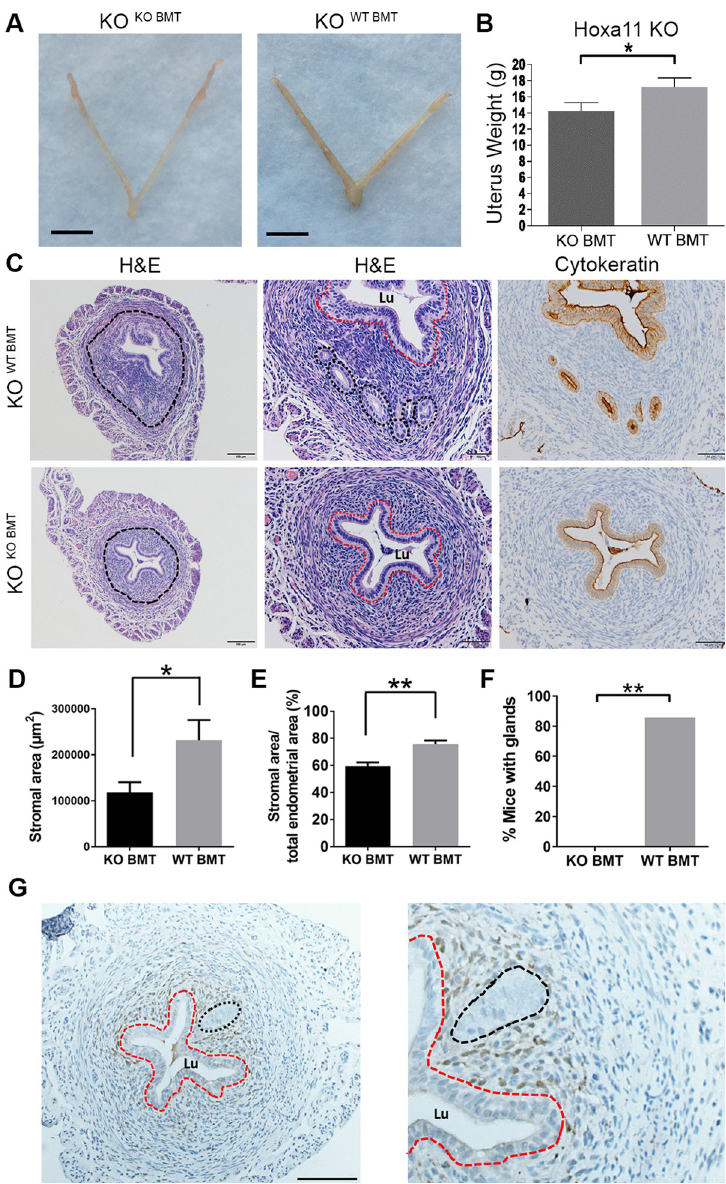
Fig 6. BM transplantation from WT donors leads to stromal expansion and induces glandular formation in HoxA11-null mice. (A and B) Uterus photographs (A) and mean uterine weight (B) of nonpregnant KO WT BMT and KO KO BMT mice. (C) HE and cytokeratin immunostaining (brown) of uterine sections from KO WT BMT and KO KO BMT mice. The endometrial area is encircled in the left panel and shown at higher magnification in the middle (HE) and right (cytokeratin) panels. Glands are seen only in KO WT BMT mice and are surrounded by black dashed circles in the middle panel, corresponding to the cytokeratin-positive (brown) areas in the right panel. The luminal epithelium (Lu) is encircled by a red dash. Scale bars, 100 μ m (left) and 50 μ m (middle and right panels). (D-F) Quantification of total stromal area ( μ m 2 ) (D), percent stromal area out of endometrial area (E), and percent mice with endometrial glands (F) in KO WT BMT and KO KO BMT groups. n = 6–7/group. (G) GFP immunostaining of uterine sections from KO WT BMT showing localization of GFP + BMDCs (brown) in the stroma. The Lu) is encircled by a red dash and the gland is encircled by black dash. Bar graphs represent mean ± SEM. � p � 0.05, �� p � 0.01. See also S15 Fig. Underlying data are available in S1 Data. BM, bone marrow; BMDC, BM-derived cell; BMT, BM transplant; GFP, green fluorescent protein; HE, hematoxylin–eosin; Hoxa11, Homeobox a11; KO, knockout; Lu, luminal epithelium; WT,